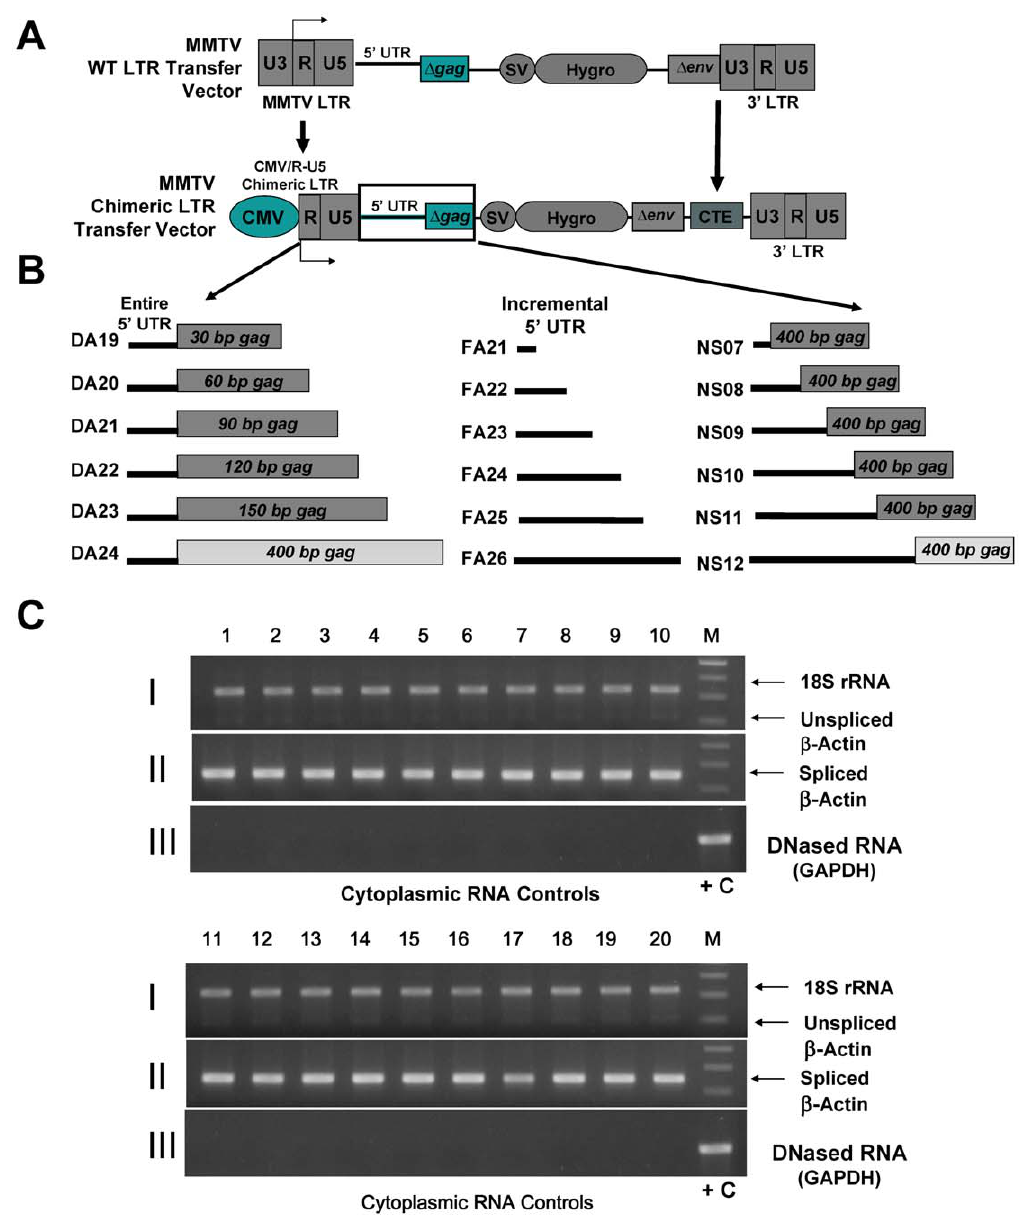
Figure 2. Improvement in the design of MMTV LTR-based transfer vectors and their test in the invivo packaging assay. ( A ) Schematic representation of the second set of MMTV transfer vectors in which the U3 region containing the promoter within the 5 9 LTR was replaced with the promoter sequences of human cytomegalovirus (hCMV) generating a chimeric CMV-R/U5 LTR. In addition, the constitutive transport element (CTE) from the Mason-Pfizer monkey virus (MPMV) was inserted between the D env and the 3 9 LTR to facilitate efficient nuclear export of viral genomic RNA in the absence of an intact MMTV Rem/RmRE export pathway. ( B ) Schematic representation of the three series of transfer vectors tested in the study containing chimeric 5 9 MMTV LTR and therefore following transfection the RNA transcription was initiated by the hCMV promoter sequences. The first series of transfer vectors (DA19–24) tested the entire 5 9 UTR in the presence of incremental amounts of gag sequences, the second series (FA21–26) tested only incremental amounts of 5 9 UTR sequences in the absence of any gag sequences, while the third series (NS07–12) tested the same incremental amounts of 5 9 UTR sequences in the presence of 400 nt of gag . ( C ) RT-PCR of cytoplasmic RNA fractions to ensure the integrity of the fractionation technique and conventional PCR on RNA samples to monitor the absence of any contaminating DNA in the RNA preparations. Panel I: Multiplex PCR amplification of cytoplasmic cDNAs with 18S and unspliced ß-actin primers; Panel II: PCR amplification of cytoplasmic cDNAs with spliced ß-actin primers; Panel III: PCR amplification of DNase-treated RNA with GAPDH primers. Lane numbers 1–18 correspond to the numbers of the three series of chimeric LTR transfer vectors (DA, FA, and NS) in sequential order, whereas lanes 19 and 20 correspond to cytoplasmic fraction from Mock (containing the packaging construct, JA10 + the VSV-G-Env expression plasmid, MD.G + luciferase-expression vector, pGL3) and no DNA transfected cultures. + C, positive control (cDNA from cellular mRNA); M, molecular weight markers.